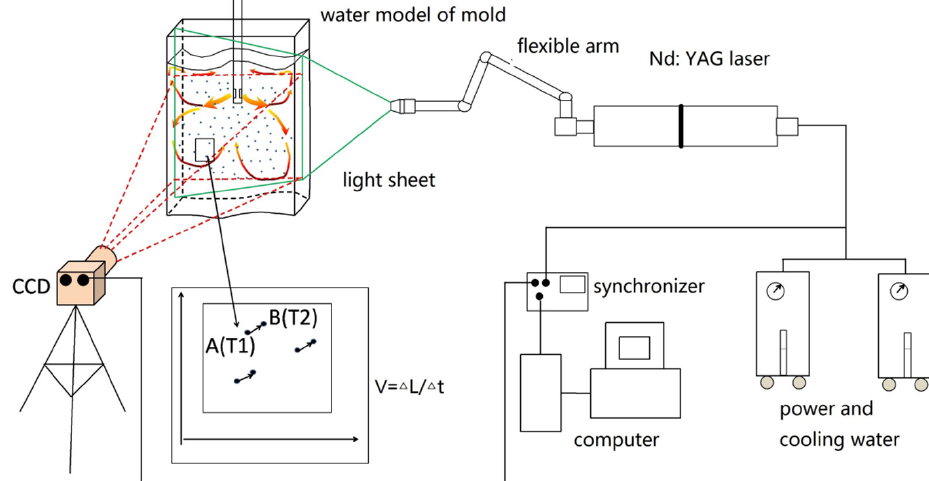
Figure 5. PIV principle.